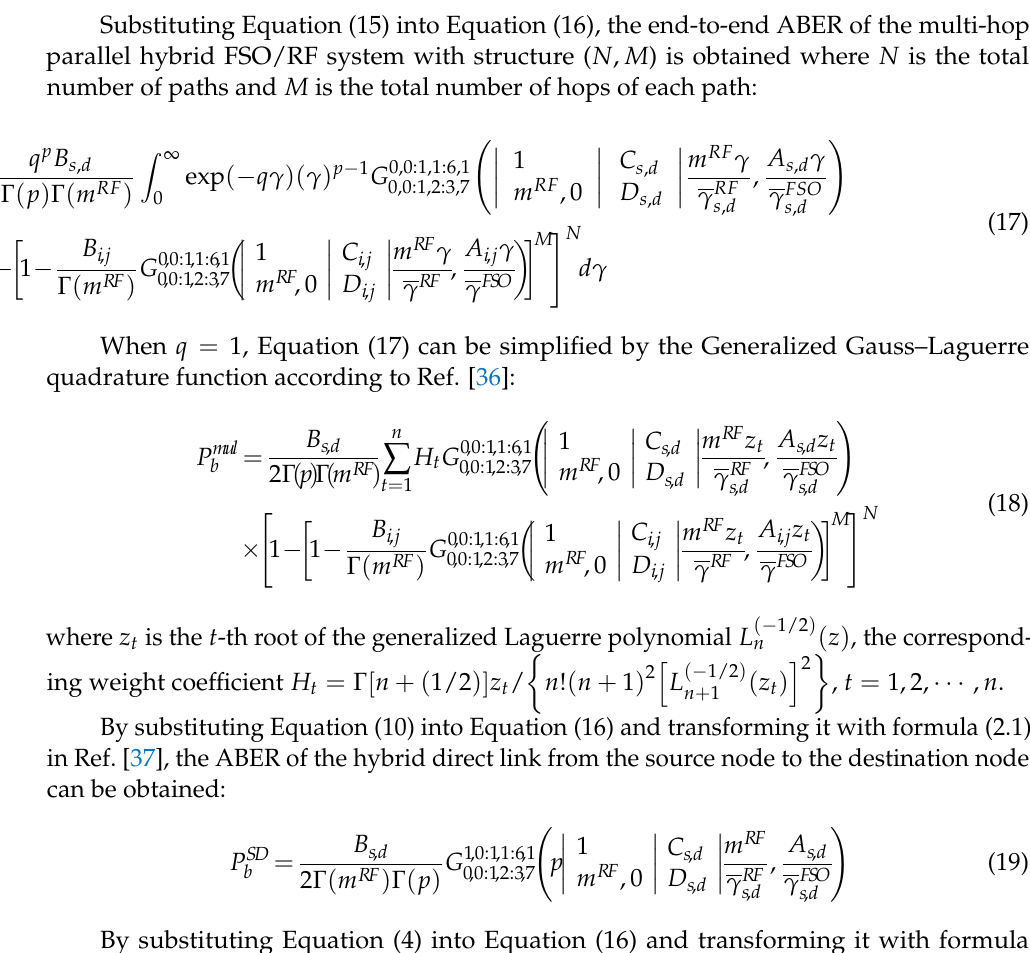
Table 1. Parameters p and q for various binary modulation scheme. Binary Modulation Scheme p q Coherent binary phase shift 0.5 1 keying (CBPSK) Differential binary phase